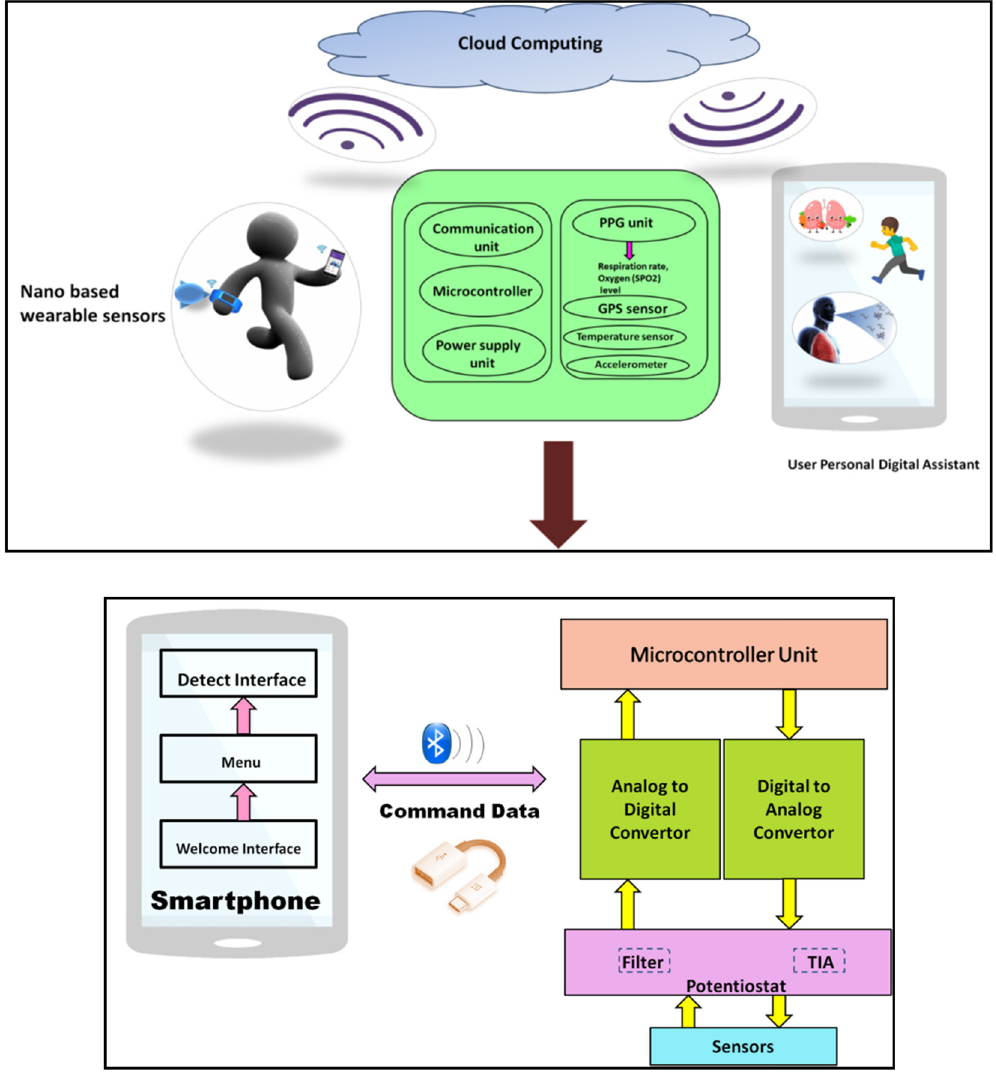
Figure 10: The operational process of the smartphone - associated voltammetry system. Modi fi cation of screen - printed electrodes to employ it as the sensor for detection of various samples [ 15,212 ] . ( Redrawn with permission from Ji et al. [ 212 ] . )